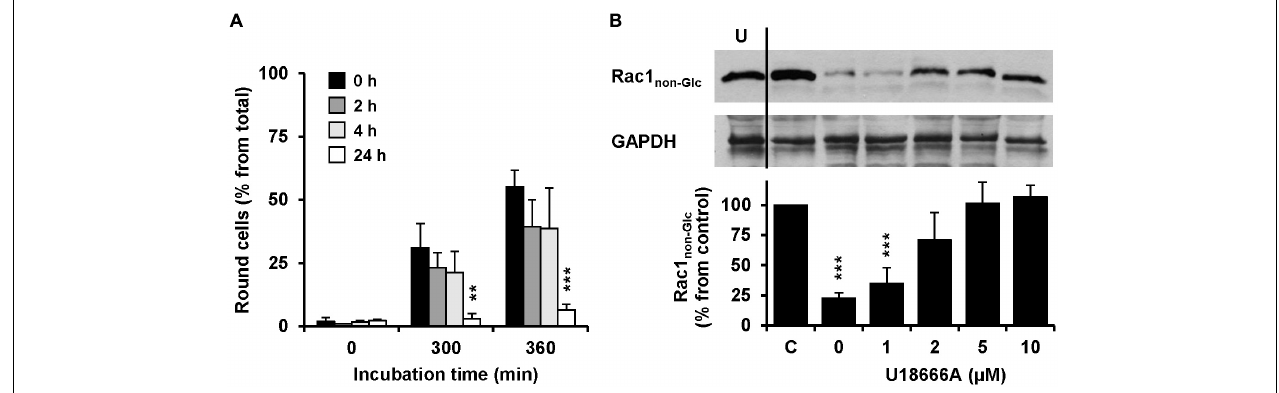
FIGURE 4 | Effect of U18666A on the TcdB-induced Rac1 glucosylation and role of U18666A pretreatment duration on TcdB-induced cell rounding in Vero cells. (A) Vero cells were preincubated for 0 h (black bars), 2 h (dark gray bars), 4 h (light gray bars), and 24 h (white bars) with the U18666A compound, prior to TcdB intoxication (10 pM) and microscopic analysis of TcdB-induced cell rounding over time. The mean percentage values of round cells at the indicated incubation times after addition of the toxin and from three parallel experiments performed in independent wells are plotted in the bar chart. Error bars represent ± SD. Asterisks indicate statistical significance at each time point compared to control (black bar) with ** p < 0.01 and *** p < 0.001. (B) Immunoblots against non-glucosylated Rac1 (Rac1 non − Glc ) and GAPDH (loading control) are shown (upper panel), obtained with whole-cell lysates that were generated from Vero cells pretreated for 24 h with increasing concentrations of U18666A as indicated and after intoxication for 120 min with 100 pM TcdB. In a control sample (C) cells were left without U18666A pretreatment and toxin addition. In another control (U) cells were preincubated with 10 µ M U18666A but were left without toxin treatment. The bar chart (lower panel) shows the quantification of the Rac1 signals (normalized with the signals of the GAPDH loading control) relative to the control sample (C), which was set to 100%. Error bars represent ± SEM, calculated from six experiments performed in independent wells (three experiments in parallel on two different days). Asterisks indicate statistical significance at each time point compared to control (C) with *** p <